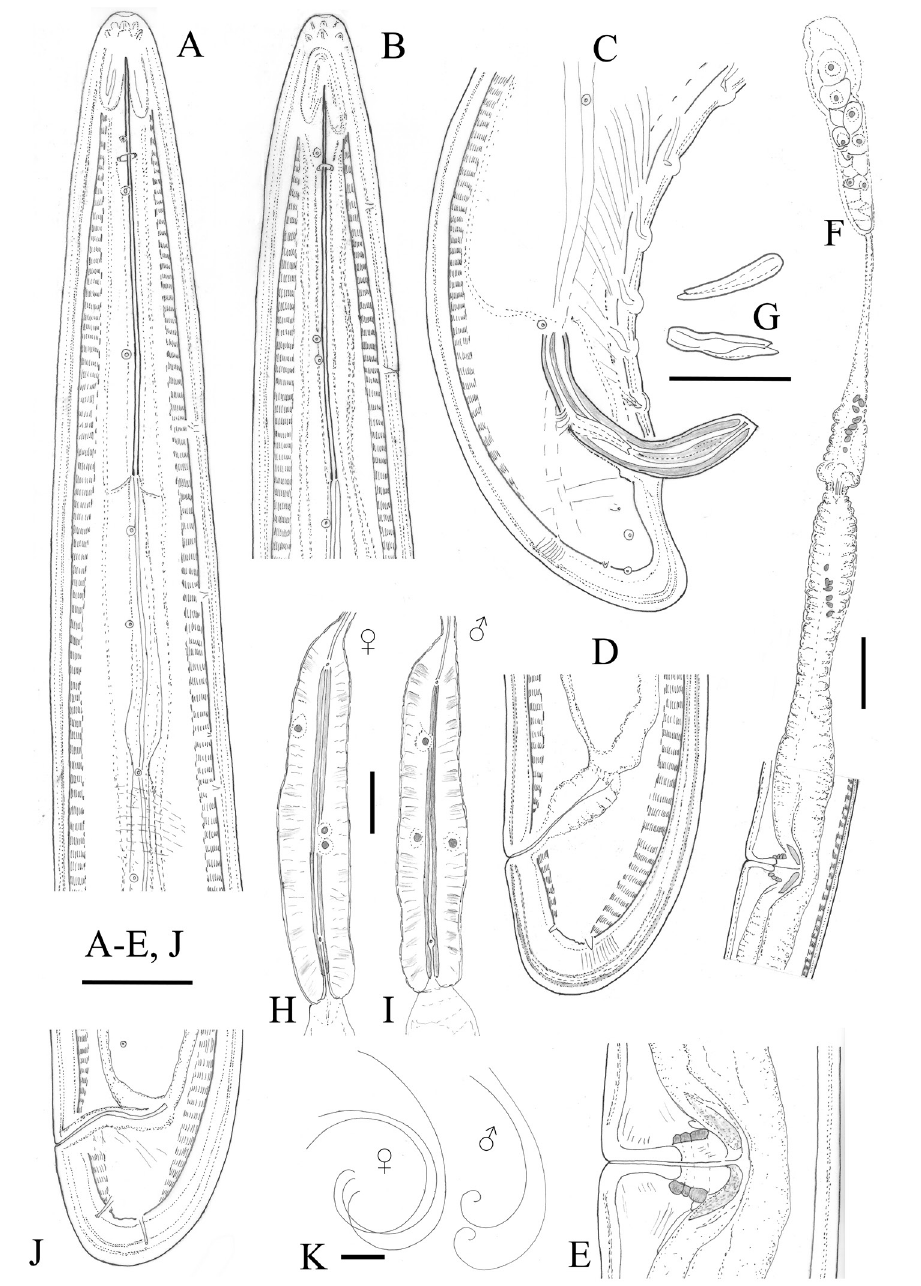
Figure 1. Longidorus polyae sp. n. A, B anterior region C posterior region D, J varia tions in tail shape E vagina F anterior genital branch G lateral pieces H, I female and male pharyngeal bulb K variations in female and male habitus shapes. Female: all except C, G and I . Scale bars: 25 μm ( A–E, J, G ); 50 μm ( F ); 1 mm ( K